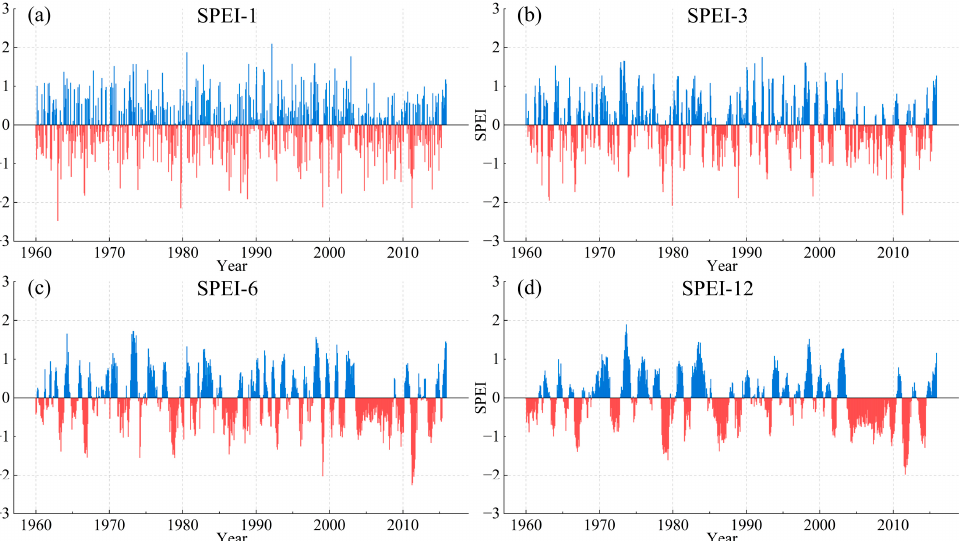
Figure 4. The interannual variations of the mean value of the SPEI on different timescales. ( a ) SPEI-1, ( b ) SPEI-3, ( c ) SPEI-6, and ( d ) SPEI-12.